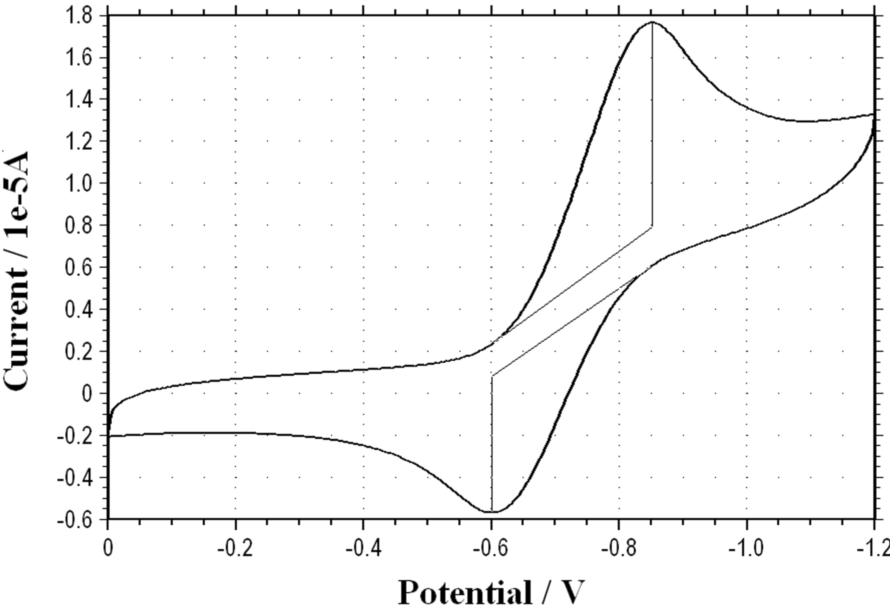
Figure 4. The spectrum of CV (Cyclic Voltammogram) for complex 1 in